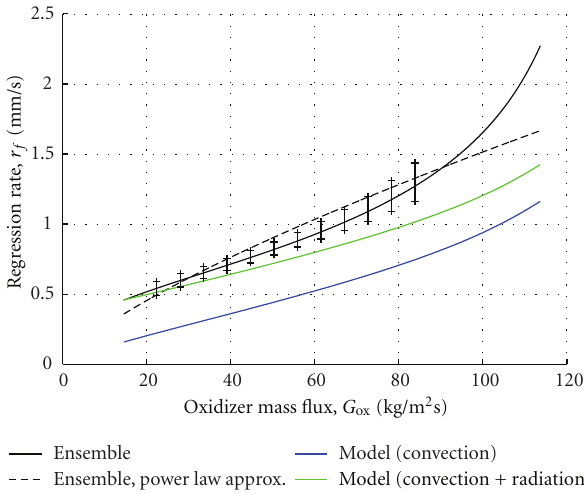
Figure 14: HTPB, loaded with ALEX and Carbon: ensemble average of experimental data for r f ( G ox ) with its power law approximation and extended Greatrix model.